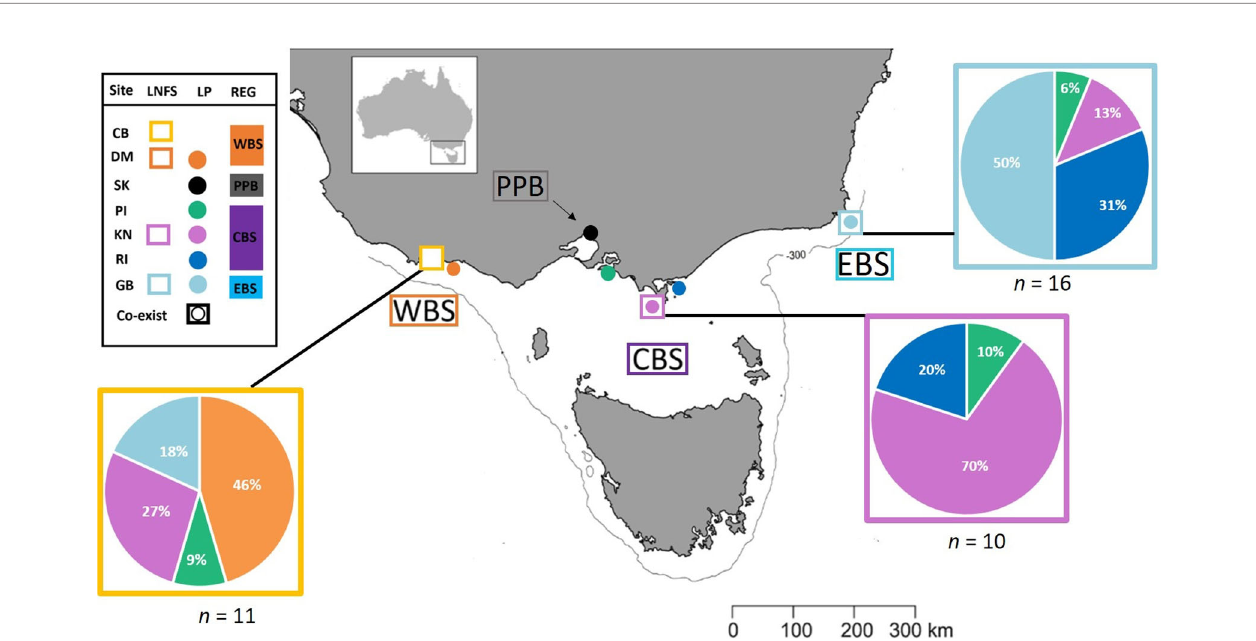
FIGURE 7 | Proportional (%) contribution of source-colonies assigned to little penguin feathers retrieved from scats of long-nosed fur seals. Plots show results of canonical variate analysis of baseline multi-elemental and isotope signatures from penguin colonies sampled across Western (WBS), Central (CBS) and Eastern Bass Strait (EBS), and Pt. Phillip Bay (PPB); Deen Maar Island and Cape Nelson (DM); St. Kilda (SK); Phillip Island (PI); Kanowna Island (KN); Rabbit Island (RI); Gabo Island (GB). Scats of long-nosed fur seals were sampled between October – November 2018.